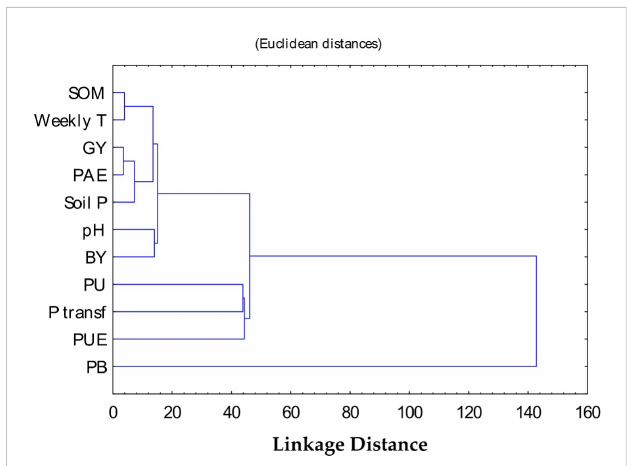
FIGURE 6 Cluster analysis (CA) of 11 traits of soil and wheat grown under calcareous conditions. Measured parameters include soil organic matter (SOM), grain yield (GY), P acquisition ef fi ciency (PAE), plant- available P (AB-DTPA) (soil P), P uptake (PU), and phosphorus (P) use ef fi ciency